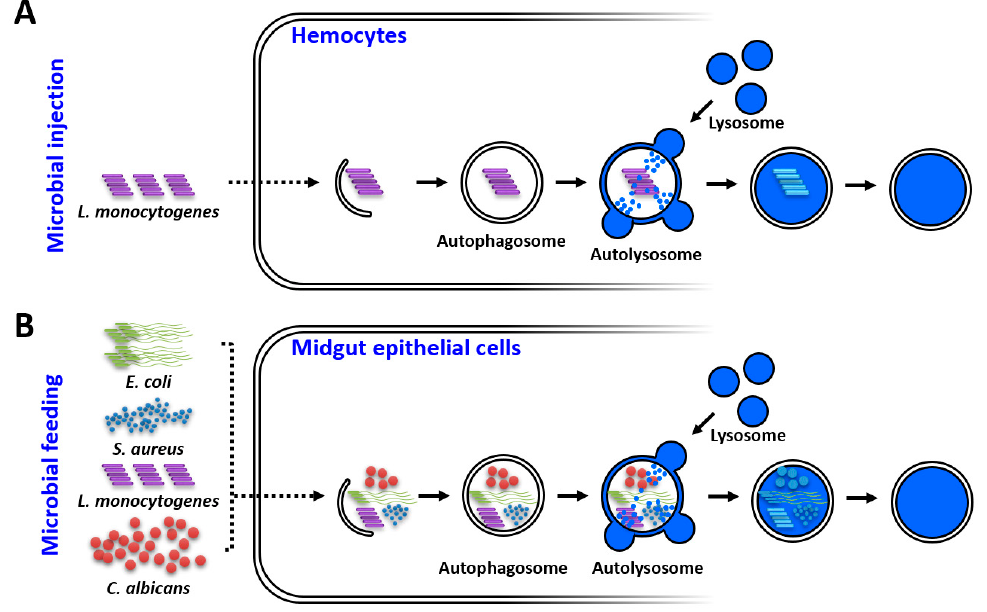
Figure 7. Graphical illustration of AaAtg8 functions in response to microbial infections by injection ( A ) and ingestion ( B ) in Ae. albopictus .